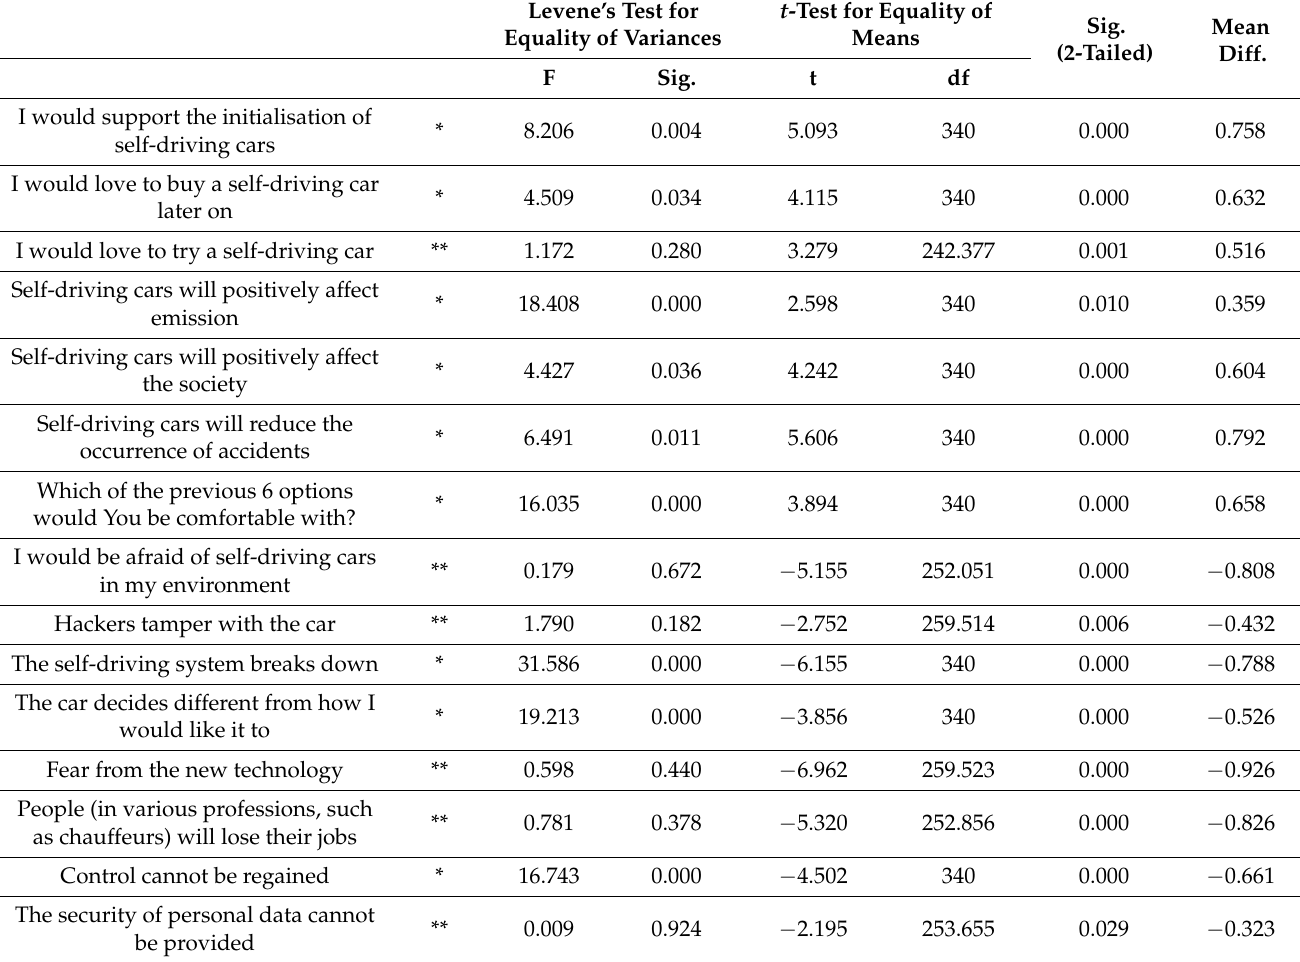
Table 2. Significant differences between male and female respondents in the Hungarian sample.